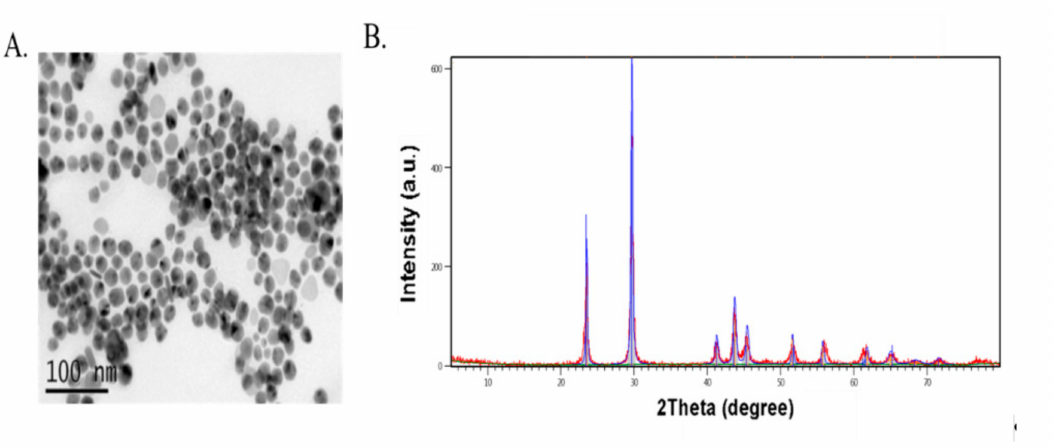
Figure 1. Characterization of nano-Se ( A , B ): ( A ) Morphology of the formed nano-Se pictured by transmission electron microscopy (TEM) and; ( B ) X-ray di ff raction (XRD) pattern of the